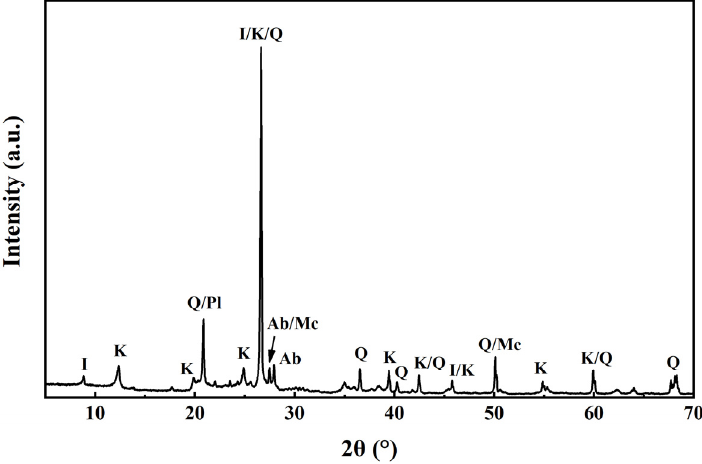
Figure 3. XRD pattern of the lab-used clay, I: illite, K: kaolinite, Q: quartz, Ab: albite, Pl: